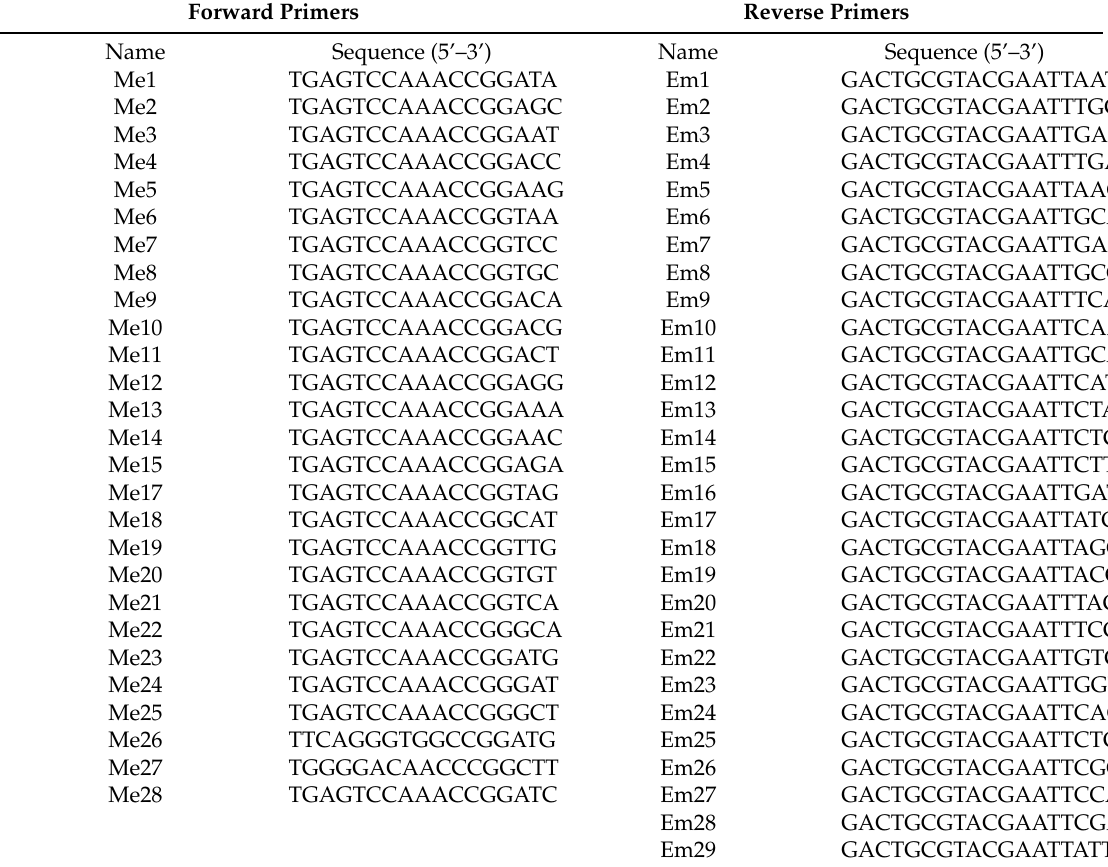
Table 2. Primers used for sequence-related amplified polymorphism